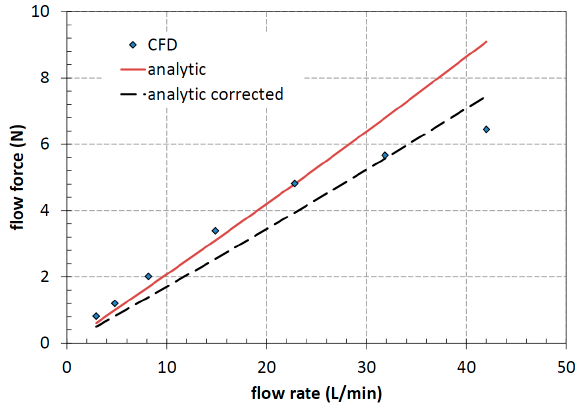
Figure 13. Flow force vs. flow rate: tuning of the analytic expression on CFD simulations.